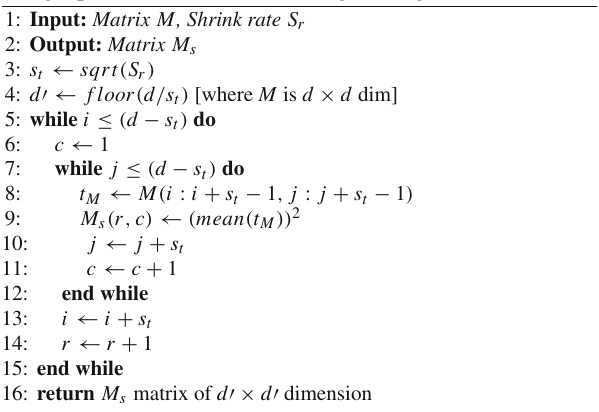
Algorithm 4 2D k − mer count matrix shrinking